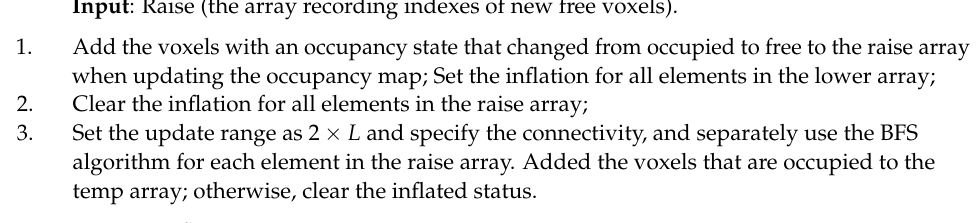
Algorithm 1. The algorithm of inflating the map for raise array. Algorithm 1 Inflate the map for raise array